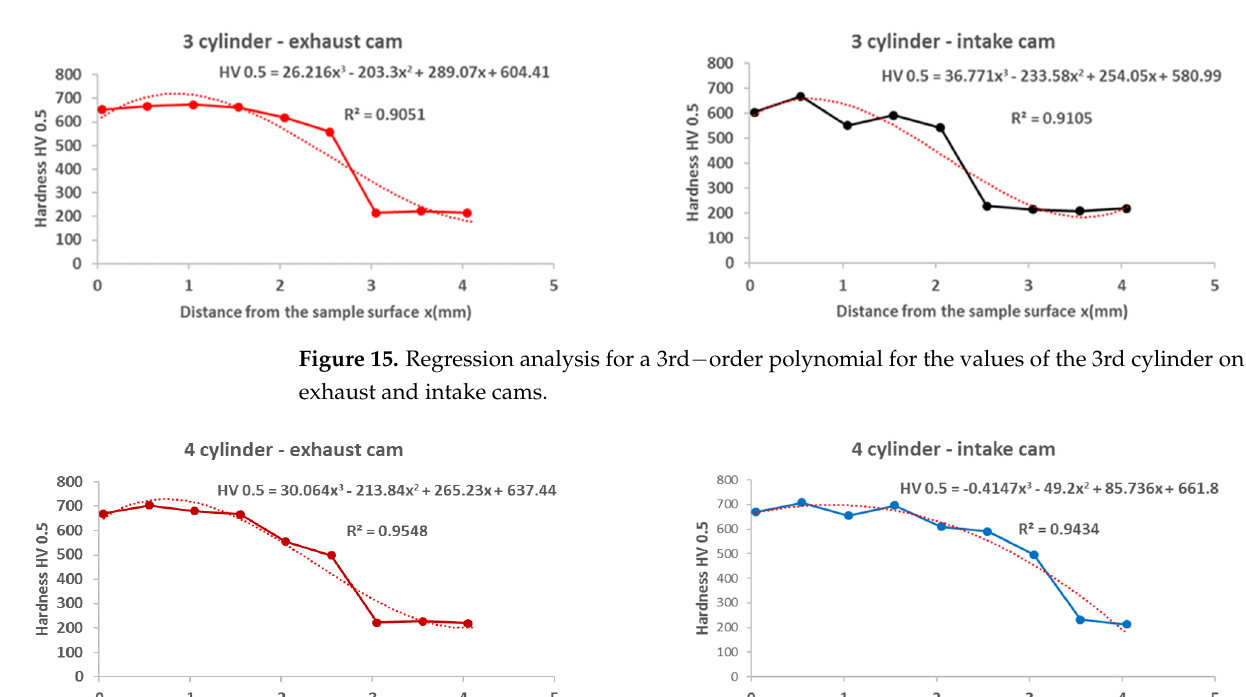
Figure 17. Regression analysis for a 3rd − order polynomial for the values of a new camshaft.